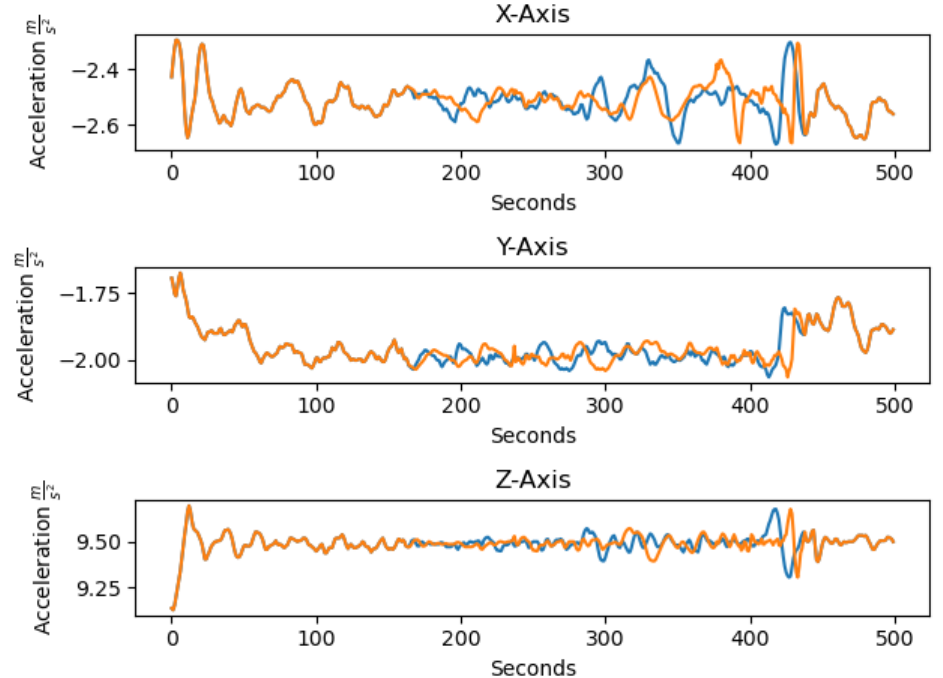
Figure 3. The difference between the raw sample and the augmented sample. The blue line is the raw sample and the orange line the augmented